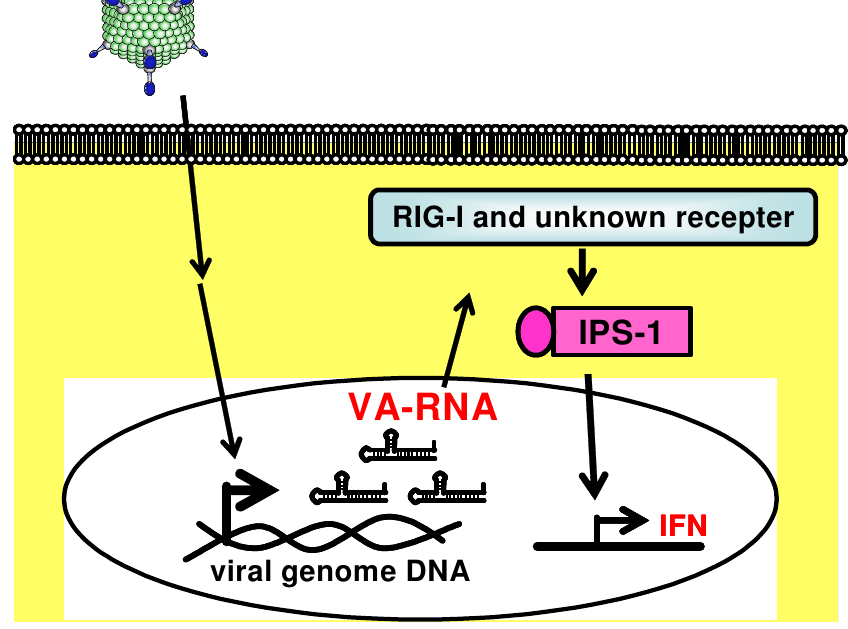
Figure 2. VA-RNA-induced production of type I IFNs through an IPS-1-mediated signaling pathway. VA-RNA: virus-associated RNA; RIG-I: retinoic acid-inducible gene I; IPS-1: IFN- β promoter stimulator-1; IFN: